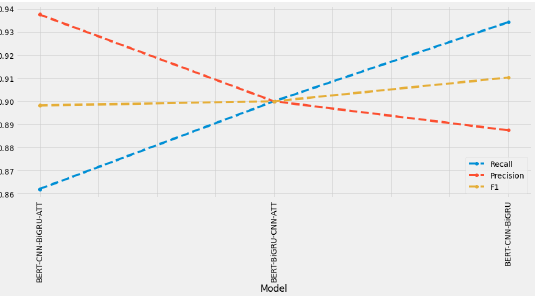
Figure 18. Performance comparisons (%) of models in PolitiFact w/o user posting behavior features.